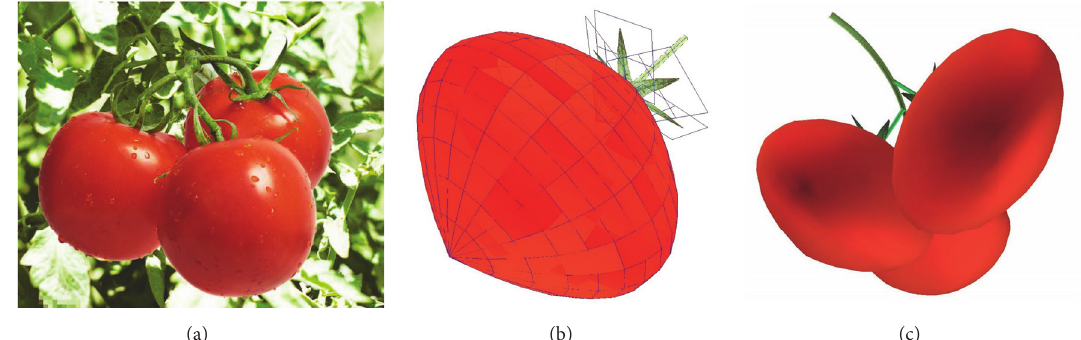
Figure 5: Modeling fruits with deformable meshes. (a) A hanging fruit. (b) Building a fruit mesh. (c) Modeling a hanging fruit.